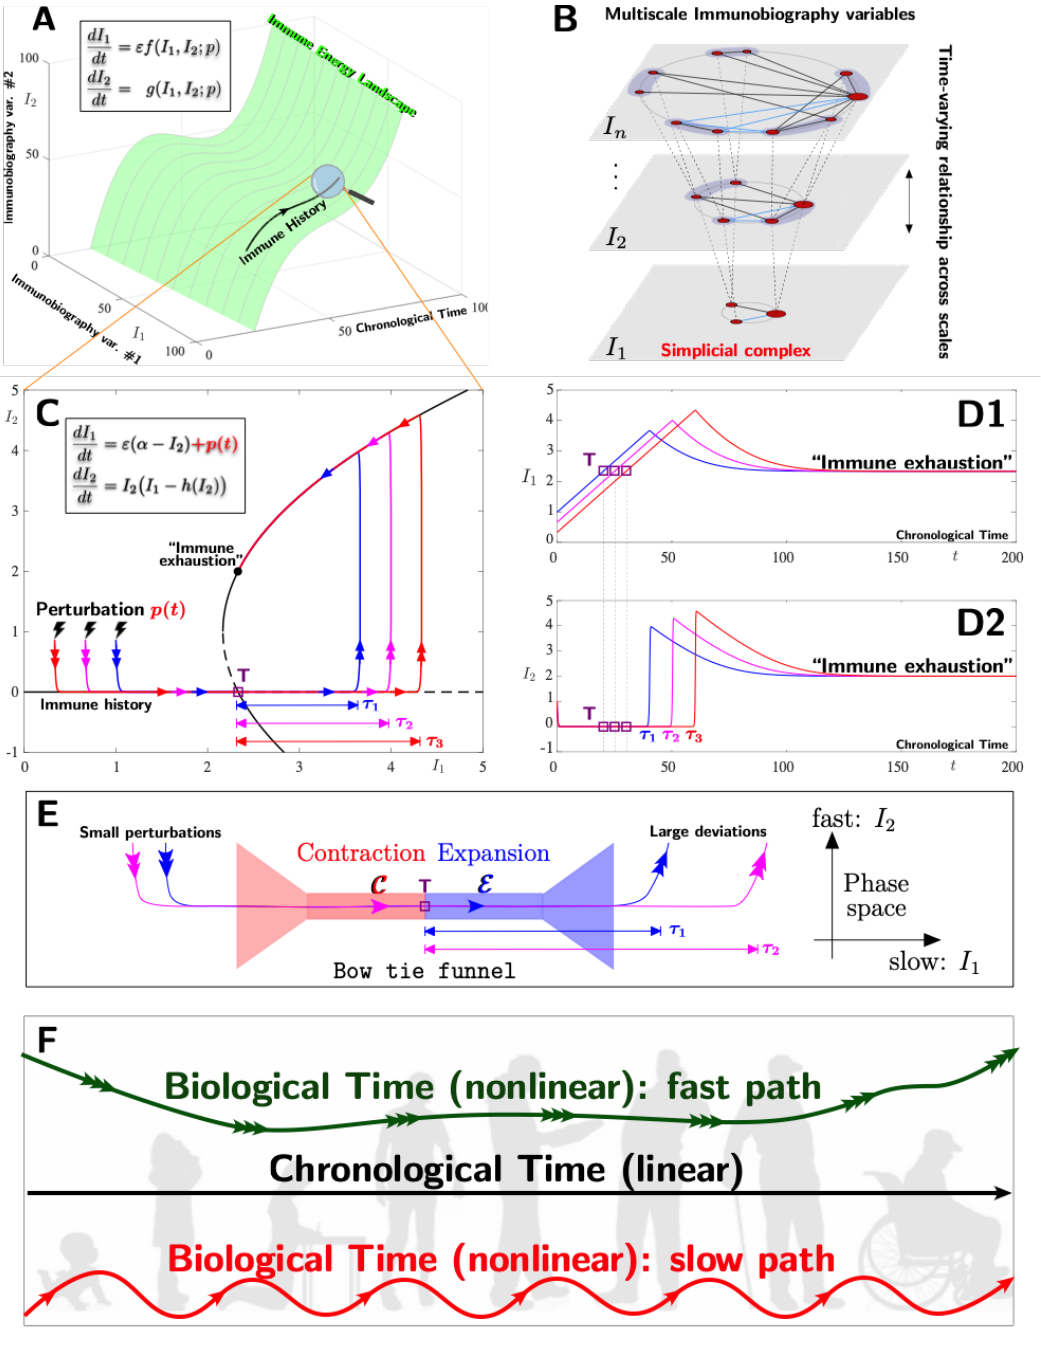
Figure 1. Mathematical modelling of the immune history and critical transitions towards differential ageing. ( Panel A ): Time-varying energy landscape (green) induced by the interaction between im- munobiographical variables with different timescales, which is given by the differential equations; the functions f and g describe the evolution law of the immunobiographical variables, as well as their interactions. Finally, ε is a small parameter, a mathematical representation to capture the idea that